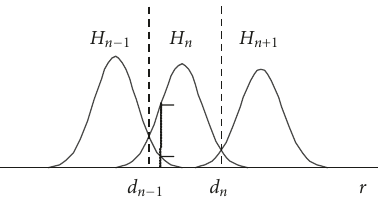
Figure 3: Gaussian